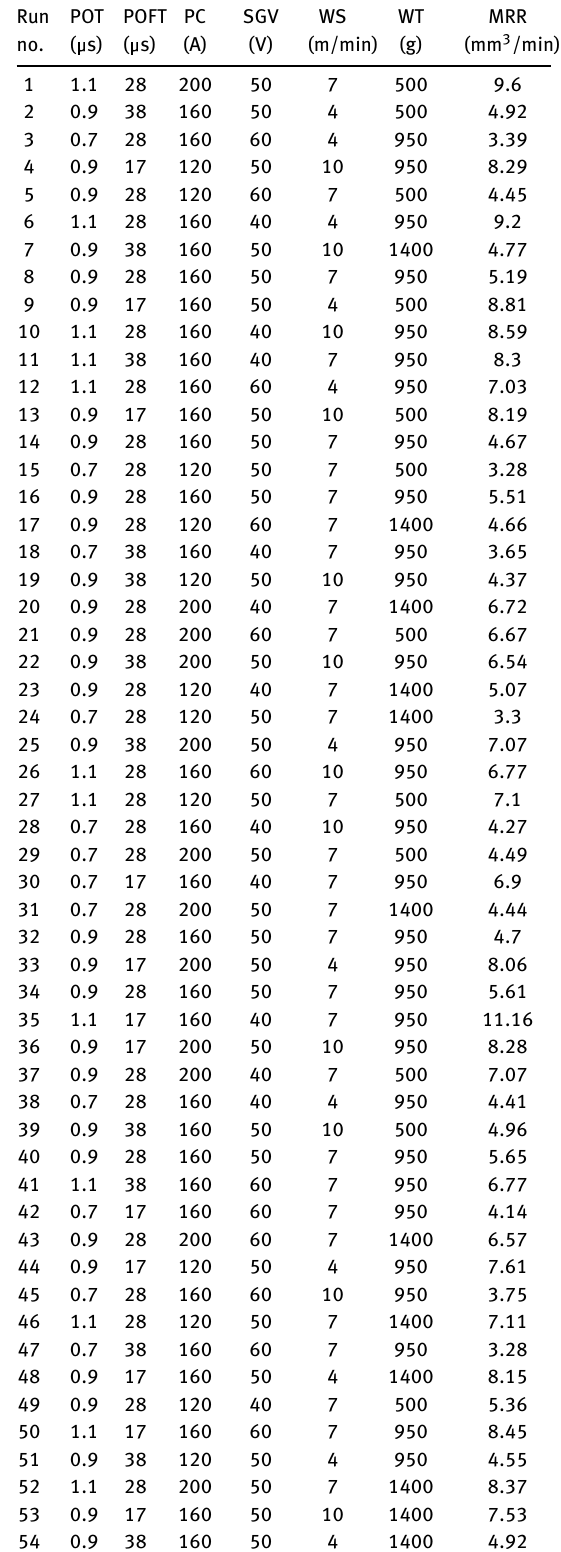
Table 2: Design matrix for main experimentation.